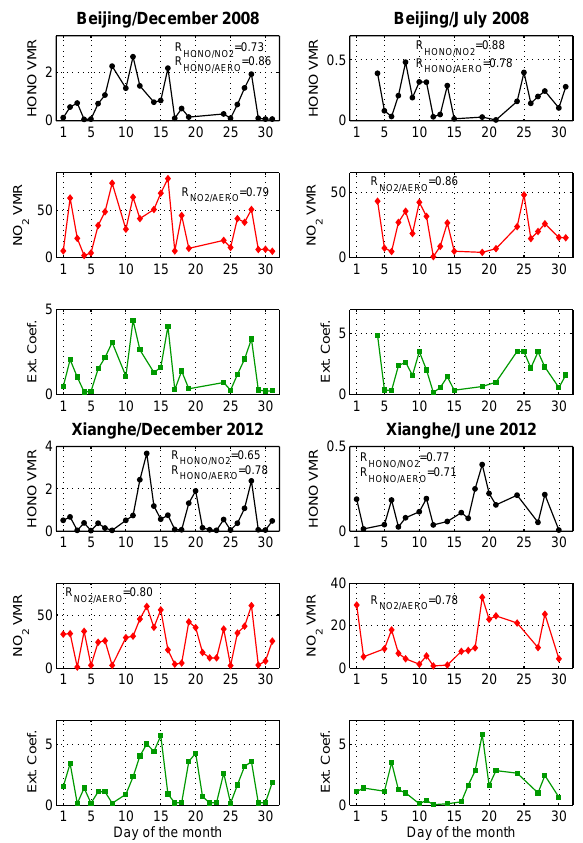
Fig. 10. Day-to-day changes of daytime HONO and NO 2 surface concentrations and aerosol extinction coefficient for one summer and one winter months at both stations. Data correspond to daily averages over the time interval of ± 2h around local noon. Similar features are obtained for VCDs and AODs. The correlation coeffi- cient values are also given in the